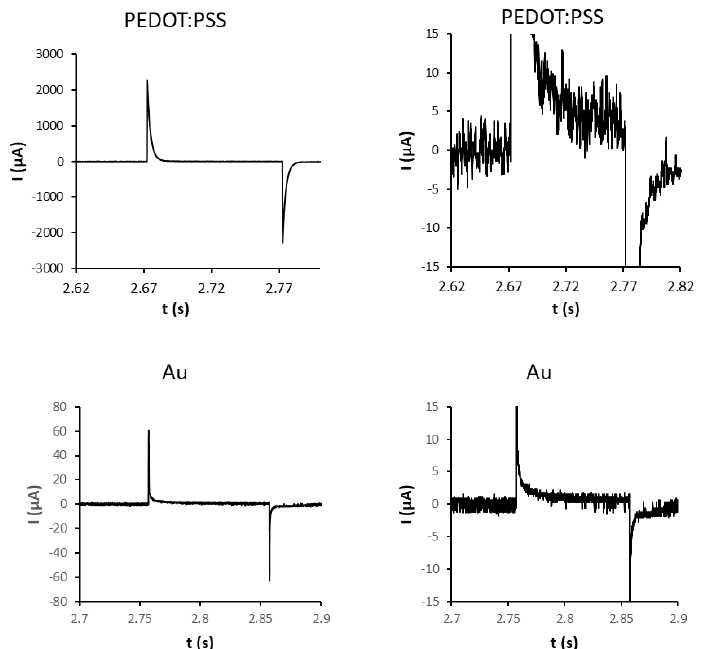
Figure 1. Chronoamperometric characteristics of PEDOT:PSS and gold platforms. Platform wells were loaded with PBS buffer. In two-electrode mode, the electric current was determined under pulses (1 Hz, 200 mV/mm, pulse duration 100 ms). Right column shows magnified views. Charts represent typical data.